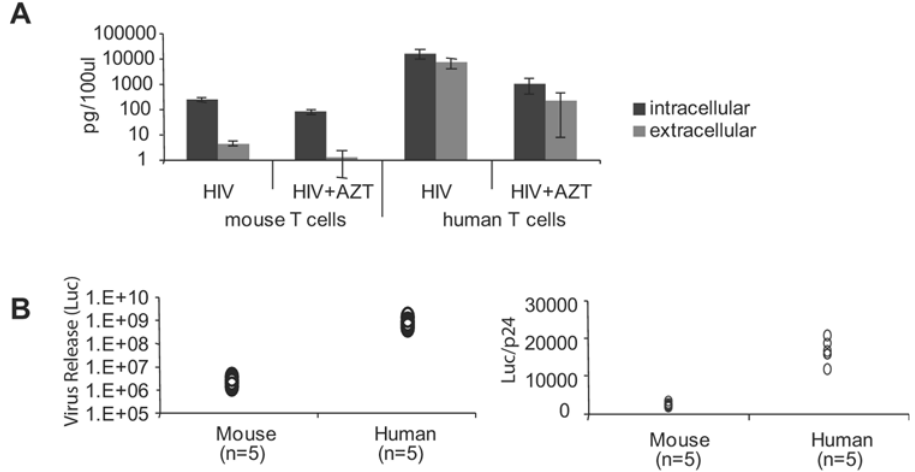
Figure 8. Primary CD4 + T cells from hCyclin T1 mice do not release virus efficiently. Activated CD4 + CD25 2 T cells were infected with VSVG-pseudotyped HIV-GFP or JRCSF at MOI of 2. Three hours post-infection, cells were washed and plated on anti-CD3 with mIL-2. Twenty-four hours post-infection, cells were treated with pronase as described in Material and Methods. Infected cells were incubated at 37 u C for an additional 24 h and checked by flow cytometry to assess viability. Cells and supernatants were collected after centrifugation. For comparison, activated human CD4 + T cells were analyzed in parallel. (A) p24 levels in cell lysates and supernatants after infection with HIV-GFP (VSVG). (B) Infectivity of virus released from cells infected with JRCSF (VSVG) was measured by adding supernatant to Tzmbl reporter cell lines. At 16 h after infection, AZT and TAK- 779 were added to Tzmbl to prevent a second round of infection. Firefly luciferase assays were performed at 48 h post-infection. Luciferase signals in mock infection control were subtracted from those in infected cells. The data represented experiments using cells from five human donors or five mice. p24 levels in the supernatant (by ELISA) were used for normalization. doi:10.1371/journal.pone.0002035.g008 correlate well with the efficiency of hCCR5 mediated virus entry. Reverse Transcription For example, a much lower percentage of human T cells can be Using HIV-1 pseudotyped with VSVG to normalize entry in stained with hCCR5 antibody, while they supported 30% of virus mouse and human T cells, we found that HIV-1 reverse entry. This could be due to the need for few hCCR5 molecules to transcription had the same kinetics in the two species. Reverse obtain virus entry. transcription products peaked around 12–15 h, which was